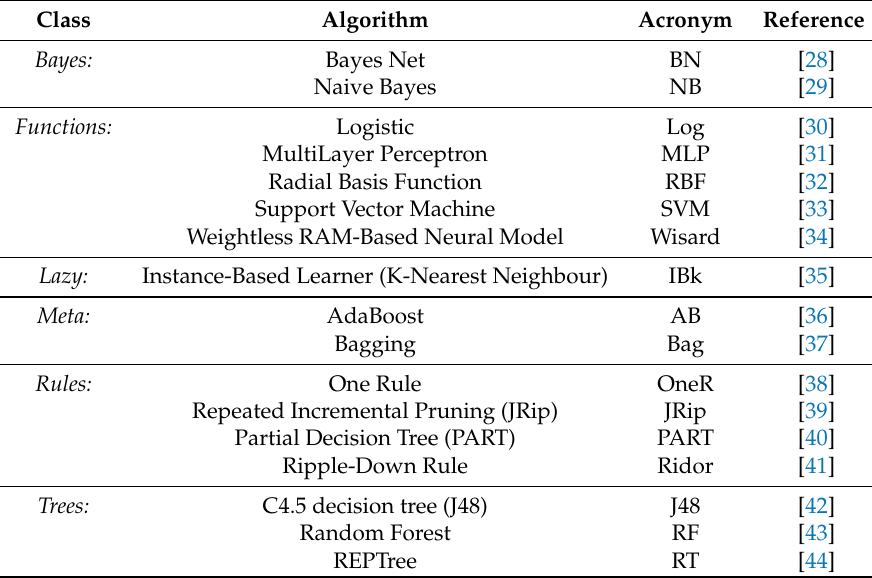
Table 2. The algorithms used here for the